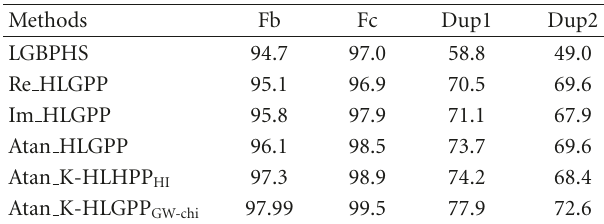
Table 1: Rank-1 recognition rate for di ff erent HLGPPs.